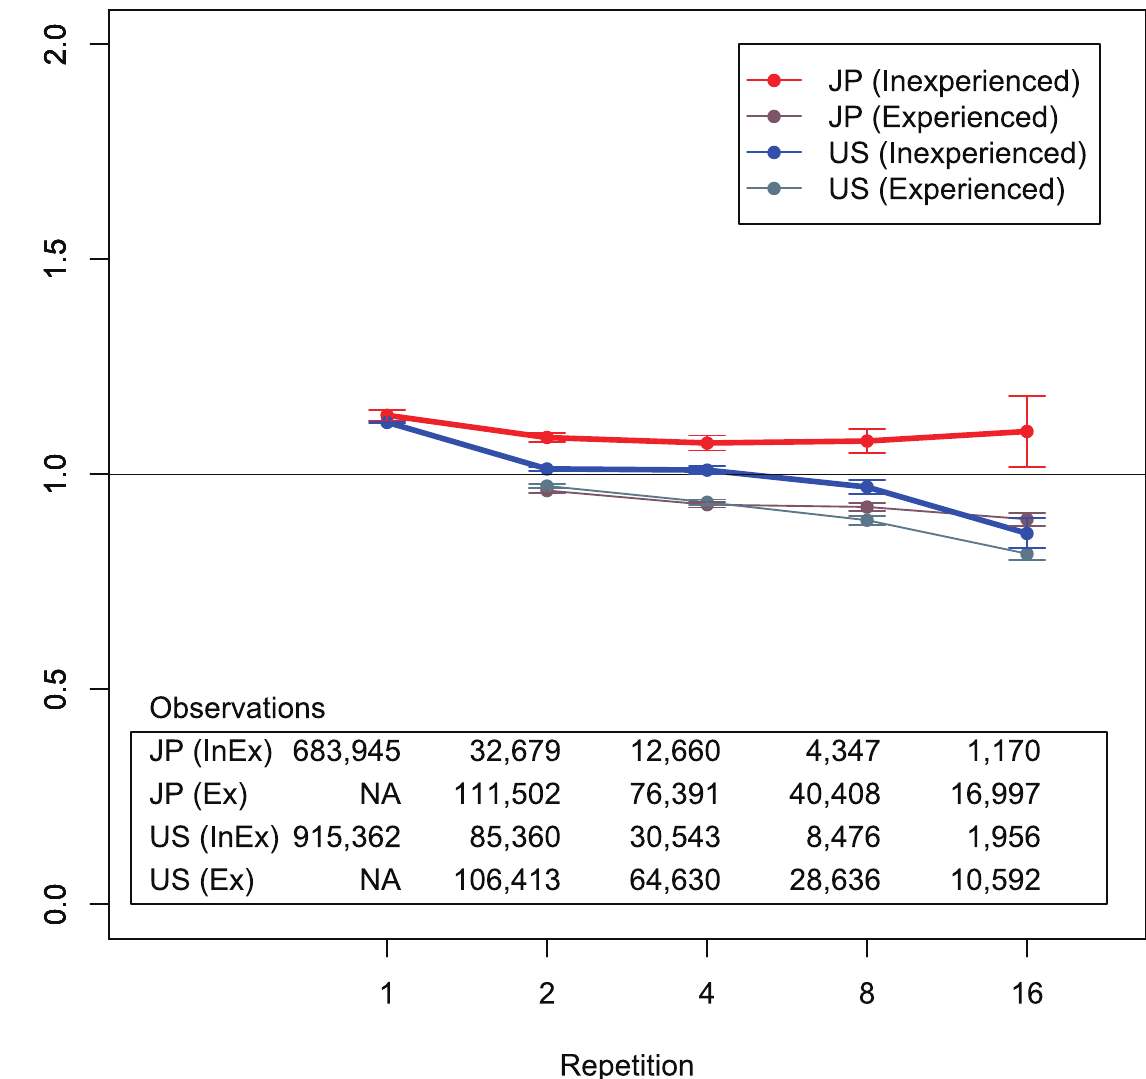
Fig 9. Average impact of repeat collaborations categorized by technological development. Horizontal axis is repetitions of team patents. Vertical axis is average impact. Brackets show standard errors. “ Inexperienced with technology ” (InEx) means patents using technologies that teams have no experience with. “ Experienced with technology ” (Ex) means the opposite. Horizontal axis is cut so that number of samples is greater than approximately 100. Black horizontal line is impact = 1.